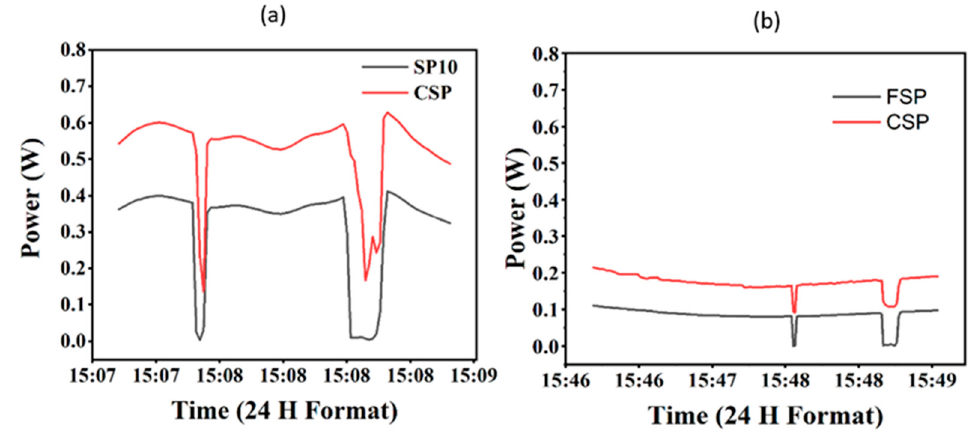
Figure 11. Power comparison with CSP for ( a ) SP10, and ( b ) textured FSP during field test